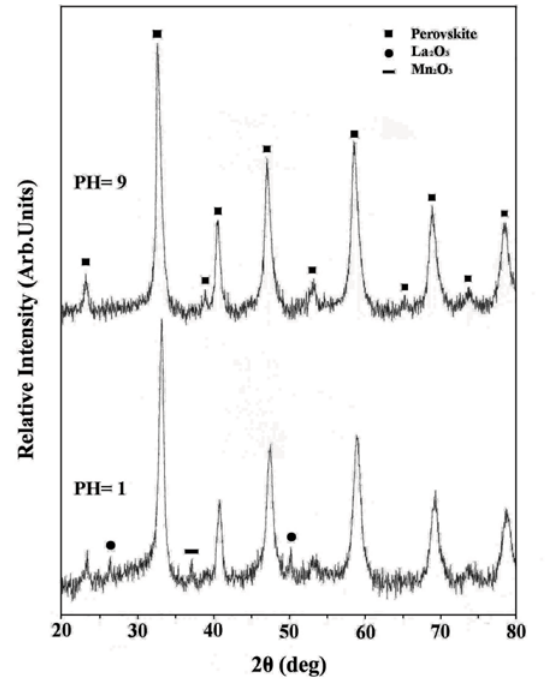
Figure 5. XRD of the powders derived from the precursor solutions with different pH values calcined at 700°C.